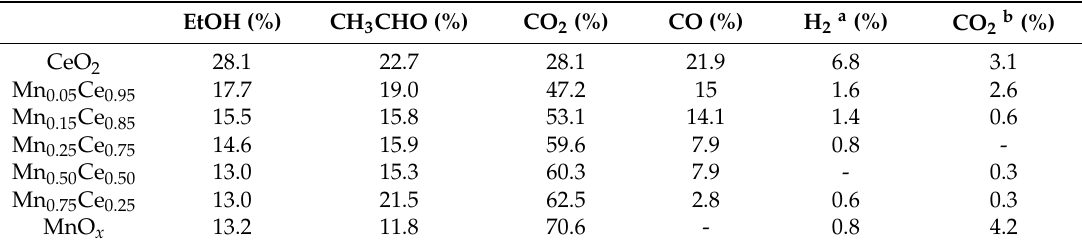
Table 1. Product distribution during ethanol-TPD over Mn x Ce 1 − x catalysts.